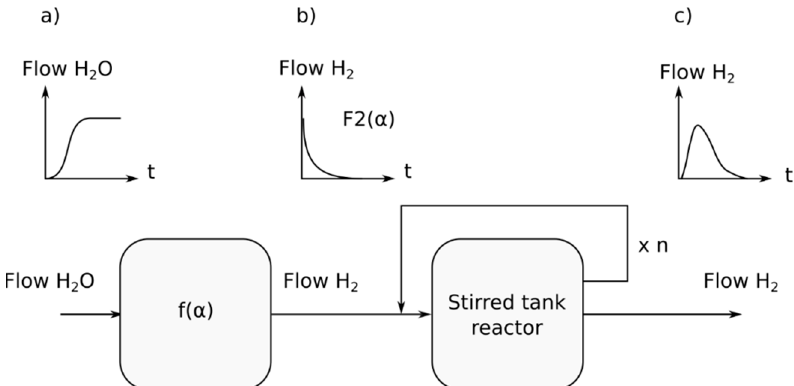
Figure 11. Schematic representation of the kinetic model used by McDaniel et al. [73], ( a ) step function of the oxidant flow introduction, ( b ) H 2 evolution profile from solid state model, ( c ) H 2 flow rate after mixing and dispersion in a continuously-stirred tank reactor.